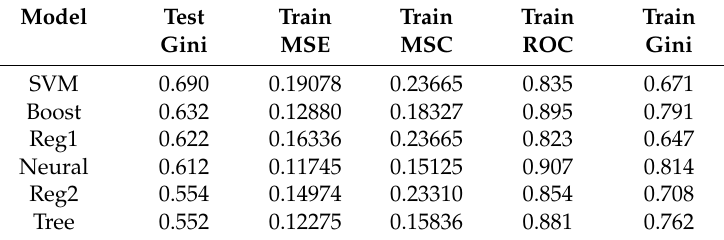
Table 6. Comparison of models based on test and train